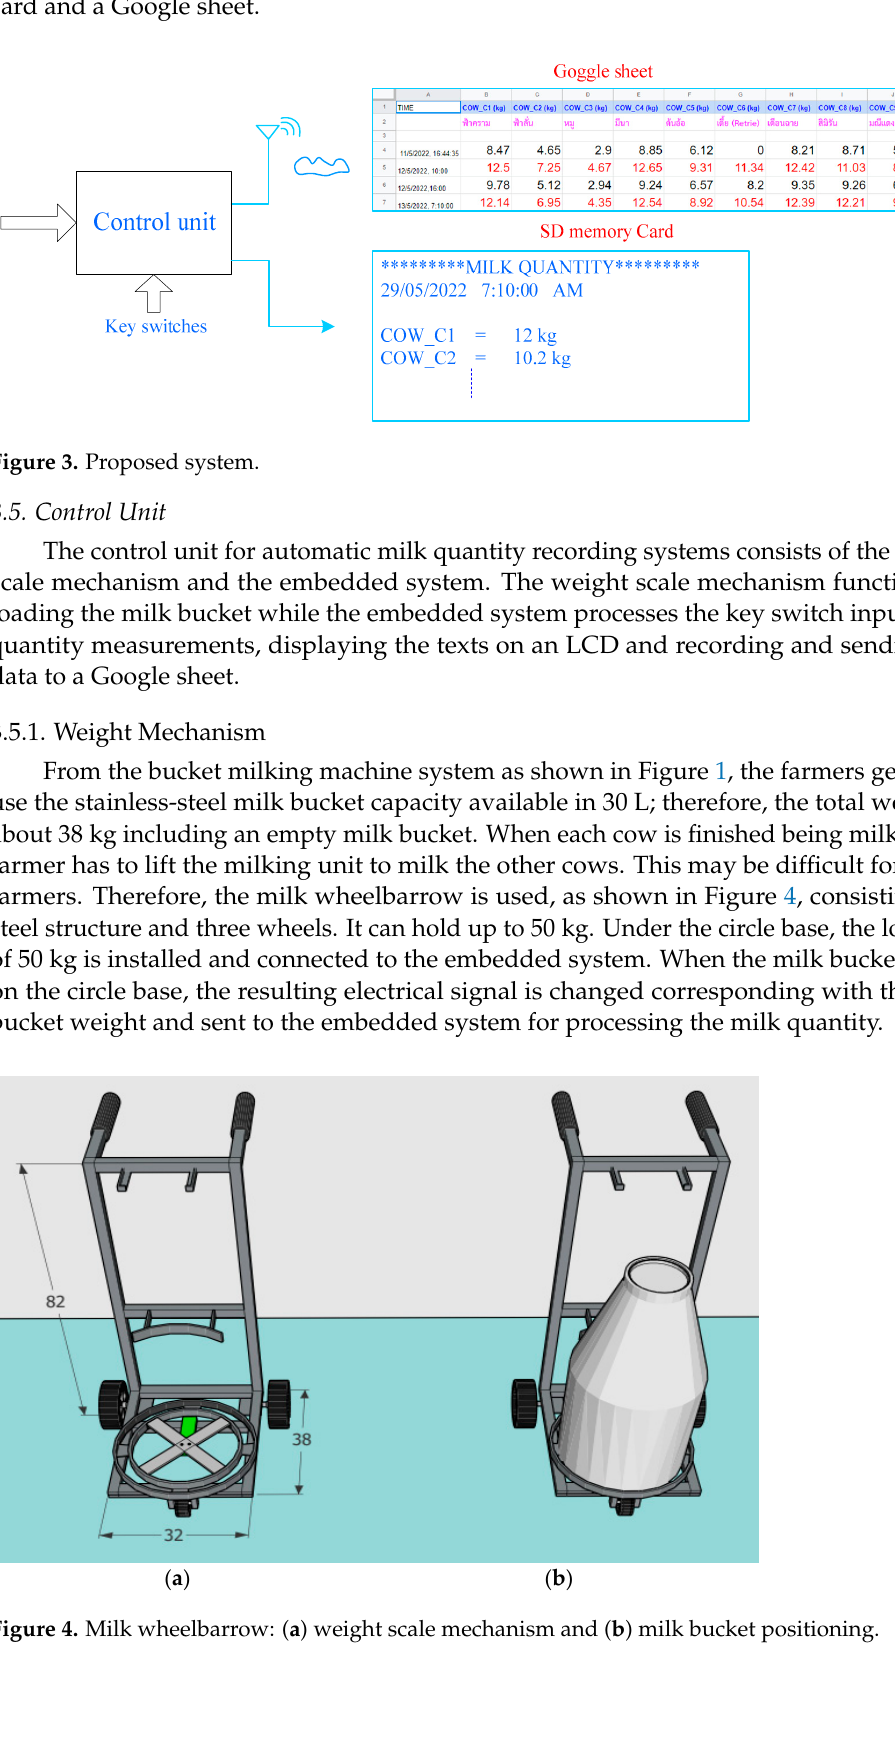
Figure 2. Milk quantity recording system by hand.